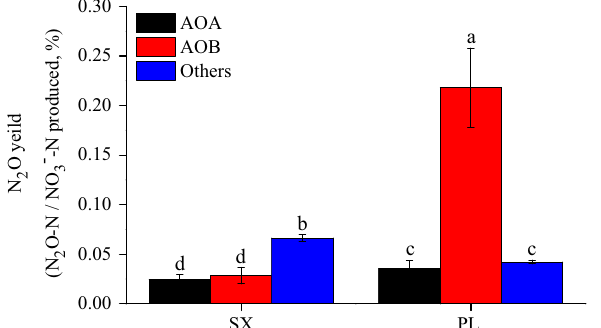
Figure 3. The yield of N 2 O associated with ammonia oxidation in NH 4+ -amended treatments; Different letters above the bars denote significant difference and the same letters denote no significant difference and error bars represent standard errors of three biological replicates.